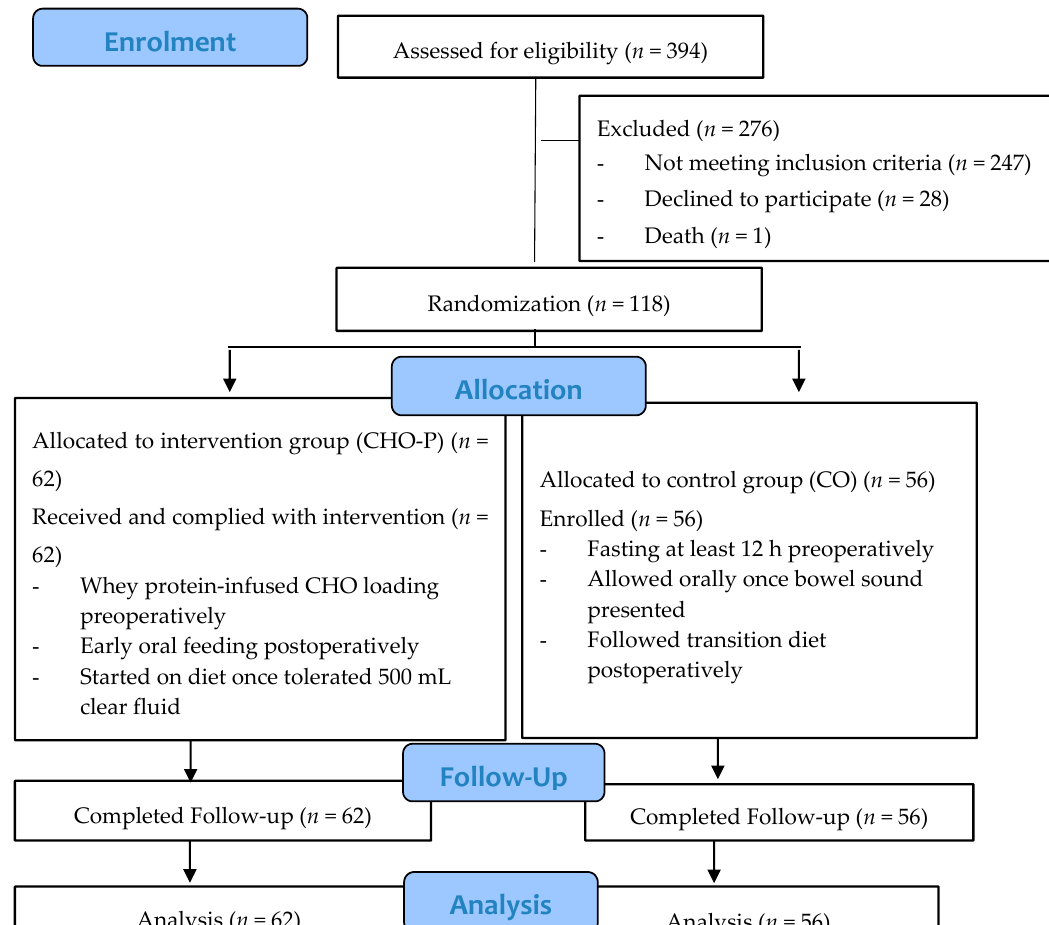
Figure 1. Flow diagram for subject screening and recruitment.